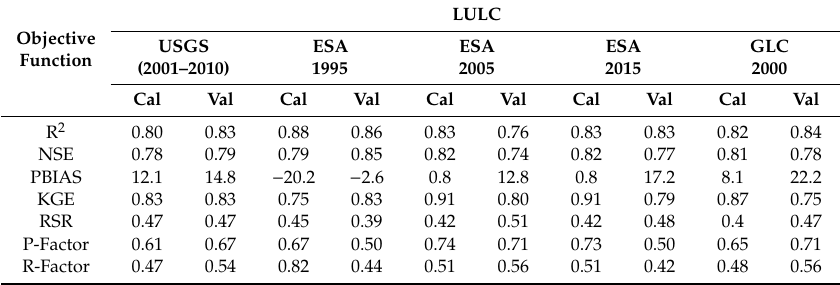
Table 3. Objective function values with observed rainfall using LULC USGS-(2001–2010), ESA (1995, 2005, 2015), and GLC-2000 China for the Tianr Hydrological Station. Objective Function